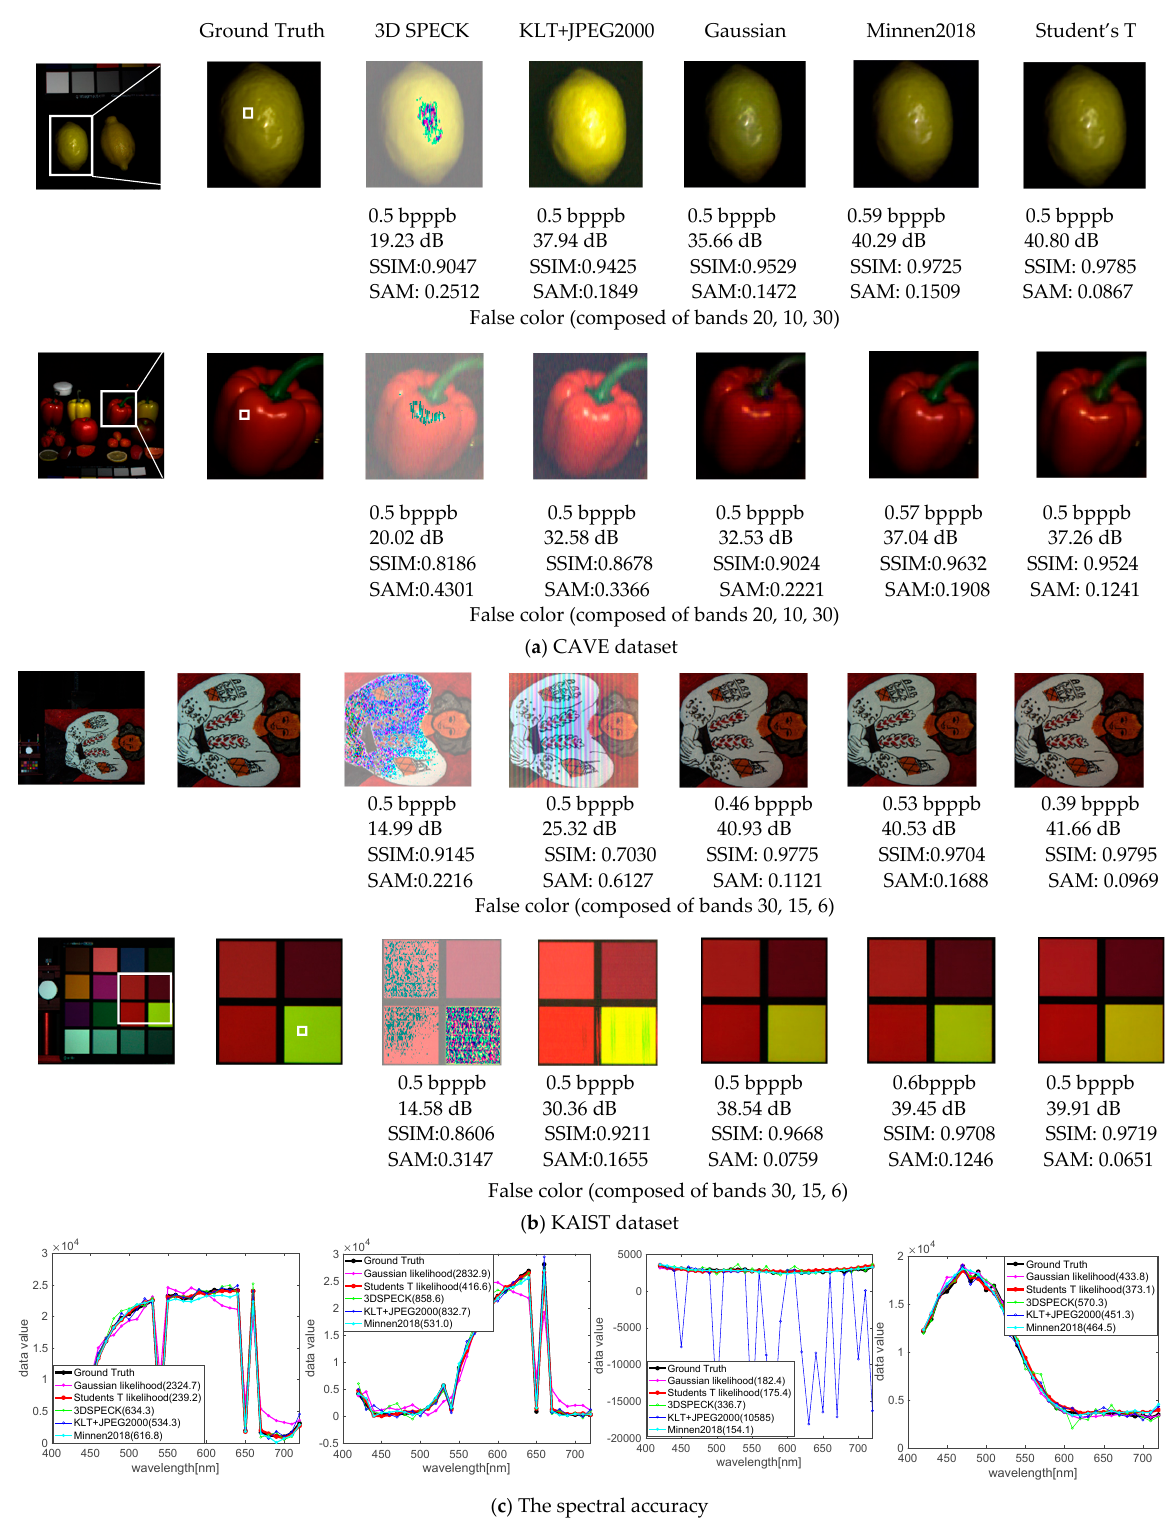
Figure 8. Rate-distortion performance displayed over CAVE and KAIST datasets. The left plots show average PSNRs. The middle plots show average SSIMs, ranging from zero and one. The right plots show average SAMs. ( a ) Rate-distortion performance displayed over CAVE; ( b ) Rate-distortion performance displayed over KAIST.